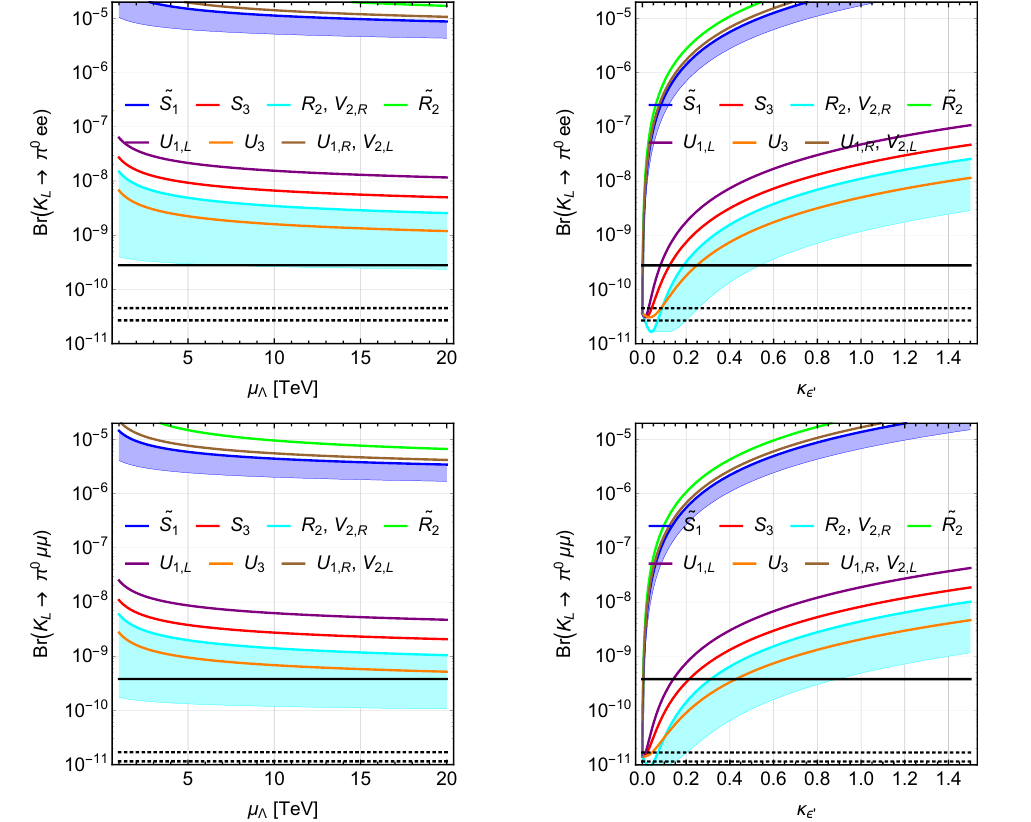
Figure 7. The dependence of B ( K L ! (cid:25) 0 e (cid:22) e ) [upper] and B ( K L ! (cid:25) 0 (cid:22) (cid:22) (cid:22) ) [lower] on the new physics scale (cid:22) (cid:3) (cid:24) M LQ for (cid:20) " 0 = 0 : 5 [left] and on (cid:20) " 0 for (cid:22) (cid:3) = 20 TeV [right], assuming the dominance of the single electronic or muonic lepton-(cid:13)avour coupling, respectively, that is purely imaginary. For U 1 and V 2 , it is assumed that either only L -LQ or only R -LQ couplings are present and saturate (cid:20) " 0 . Further shown are the current upper experimental bounds on B ( K L ! (cid:25) 0 ‘ (cid:22) ‘ ) [black solid] and the SM predictions [black